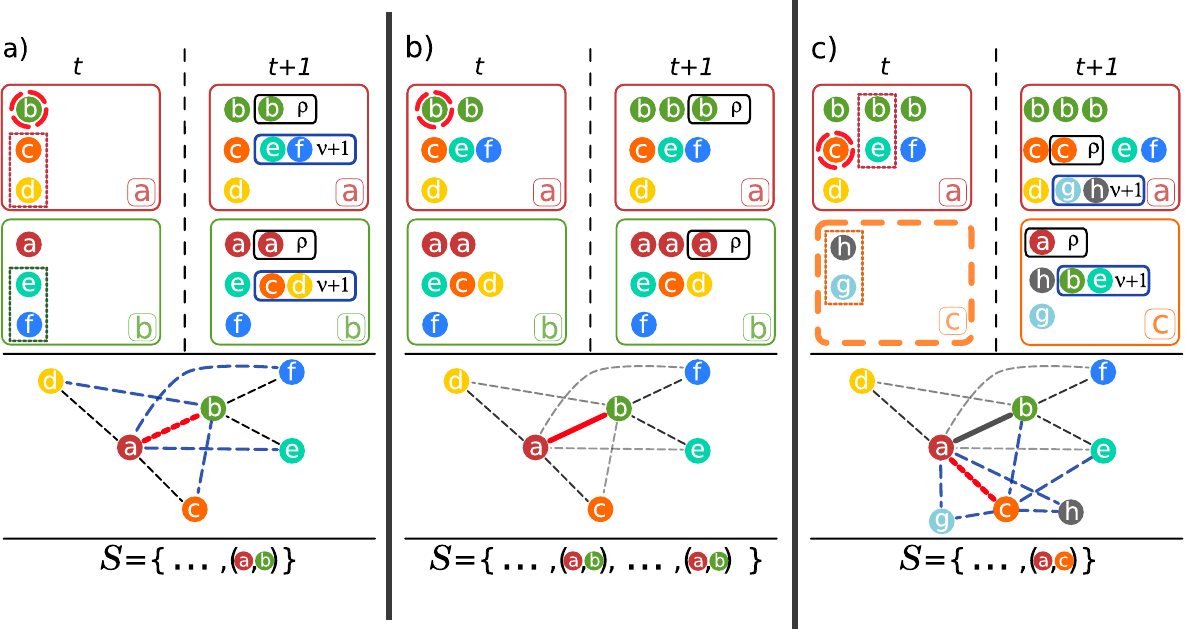
Fig. 3 Three possible evolutionary steps of the model. Three possible steps of the Polya ’ s urn model for a system with equal reinforcement and innovation parameters ρ = ν = 1 with the weighted sampling with withdrawal sampling strategy s = WSW. For each evolutionary step of the system (columns), we show the current state of the urns (top row), the equivalent network evolution (mid-row), and, the sequence S of observed events (bottom row). In the network, we show already active links (solid lines), links in the adjacent possible space (dashed lines), currently active links (red lines) and connections entering into the adjacent possible space (blue dashed lines). The ball drawn is visualised with a red dashed circle while we show reinforcement balls and memory buffer ones enclosed in black and blue rectangles, respectively. New urns entering the system are shown with dashed borders. a At time t urn a is active and draws the ball b : the event ( a , b ) is then appended to the sequence S . At time t + 1 the urn a then gains ρ copies of b and vice-versa (reinforcement) and, since the e ab link is new, we also draw ν + 1 distinct balls from a following the WSW strategy (balls c and d within the dashed rectangle) that will be copied into b (and the same for b that sends e and f as novelties to a ). In the network representation, the e ab edge is active and the e ae , e af , e bc , and e bd links enter into the adjacent possible space. Notice that the adjacent possible of c changed without the need for c to participate in social interaction. b At time t , urn a draws a copy of b (top). Since the edge e ab was already active in the past, we only put ρ copies of b in urn a and the other way around. The network ’ s topology does not change in this step, while the weight of the e ab link gets increased (network representation). c Urn a draws a copy of c at time t (top). Since c is an empty urn, it creates ν + 1 novel IDs ( g and h , in the dashed rectangle) and gains a copy of them. We add ( a, c ) to the sequence S and we perform the reinforcement/novelties exchange between a and c . The network gains two new nodes ( g and h ), activates a new edge ( e ac ) and inserts new links in the adjacent possible space. The actual space of c acquires a while its adjacent possible space gains e , g , and h